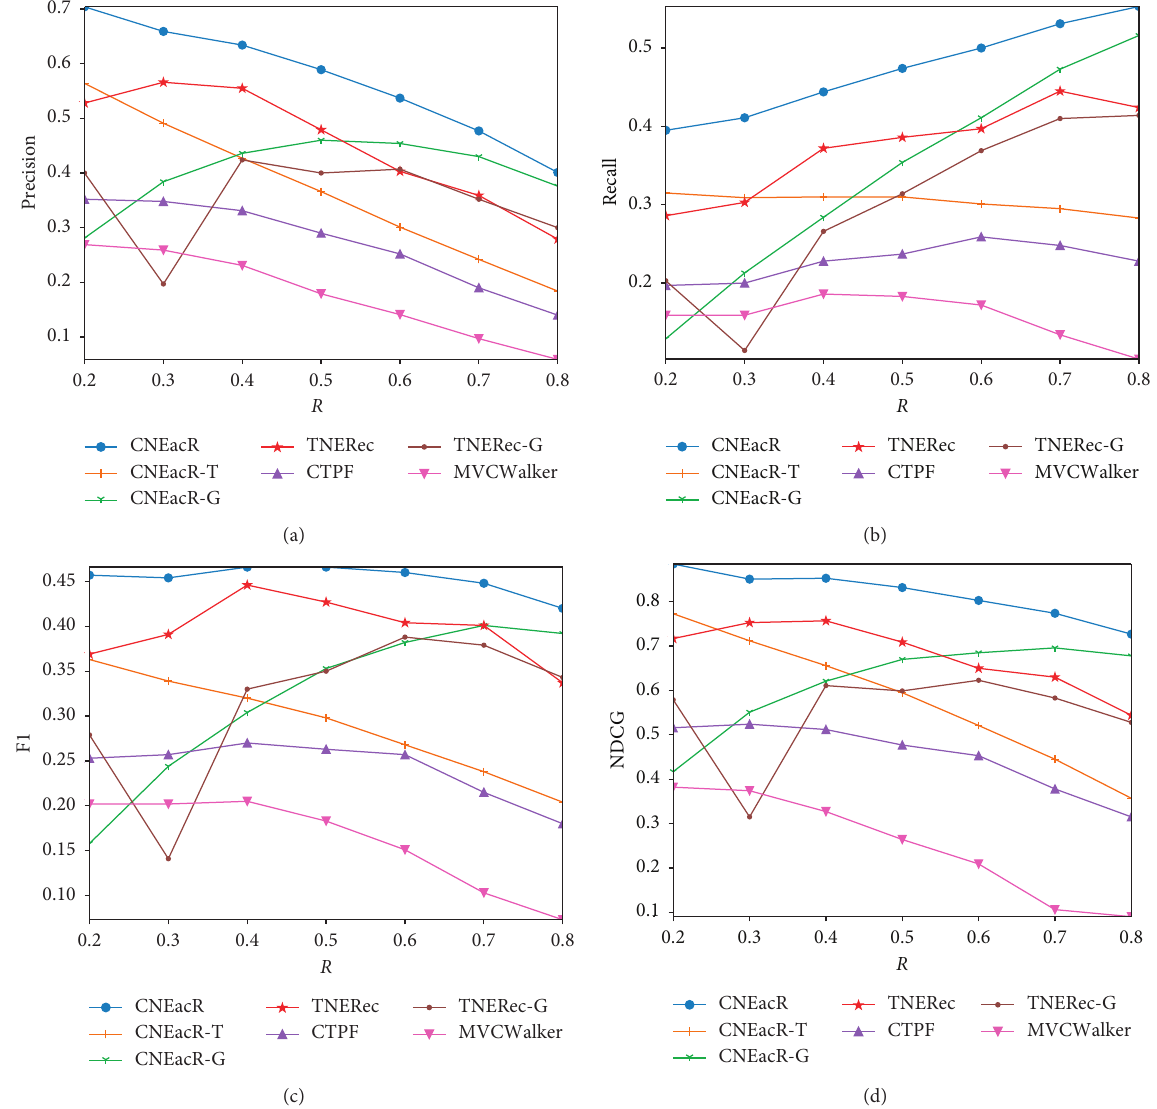
Figure 5: Performance in different R . (a) Precision in different R . (b) Recall in different R . (c) F1 in different R . (d) NDCG in different R